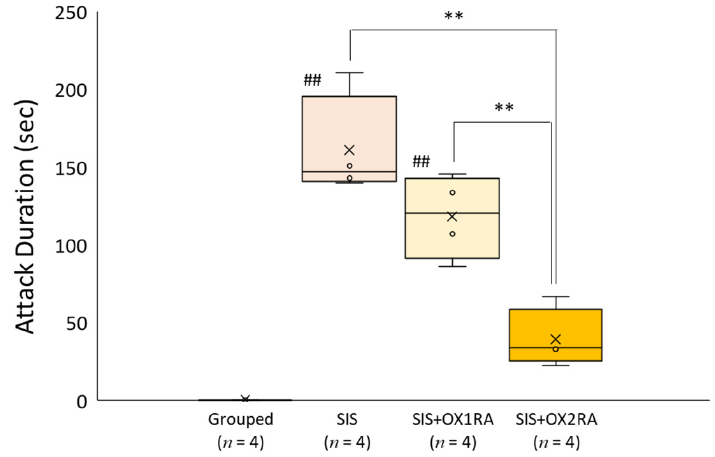
Figure 6. Aggressive behavior test following the treatment of orexin receptor antagonists. Attack durations during the 10 min aggressive behavior test. Increased attack duration induced by social isolation stress was significantly inhibited due to OX2RA treatment (** p < 0.01). Horizontal lines within boxes denote median values, and x-marks denote mean values. * p < 0.05, ** p < 0.01, ## p < 0.01 vs. Grouped. SIS, social isolation stress; OX1RA, orexin-1 receptor antagonist; OX2RA, orexin-2 receptor antagonist.